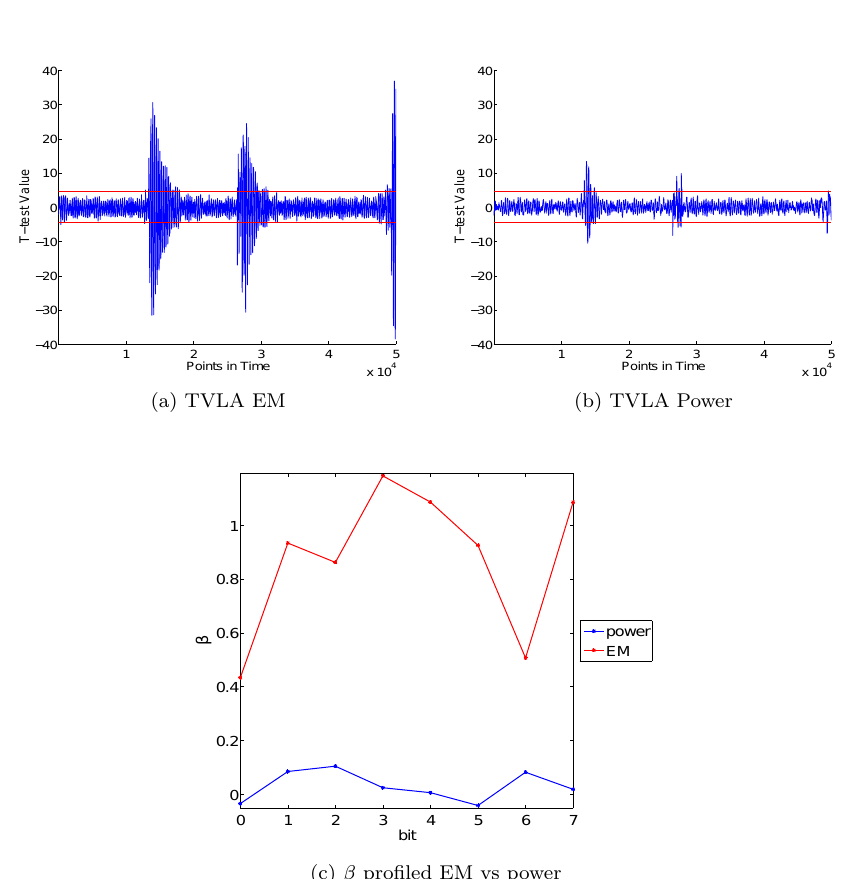
Figure 11: Leakage profiling comparison: EM vs Power. (Upper Figures) The red lines indicate the upper and lower limits of the TVLA threshold ( ± 4.5). (Lower Figure) The β coefficients obtained from EM and power under the same setup.